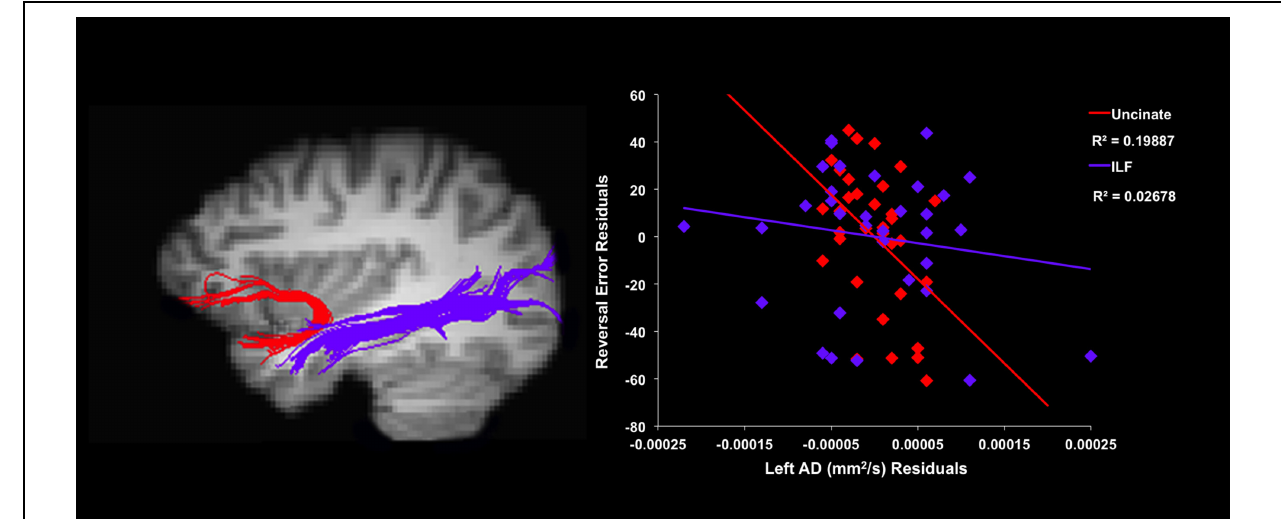
FIGURE 2 | Tractography delineating the uncinate fasciculus (UF; red) and inferior longitudinal fasciculus (ILF; purple) in a sample participant (left). Scatter plots of residuals from the linear regression analyses (right) illustrating the relationship between individual differences in reversal errors and mean left axial diffusivity (AD) of the respective white matter